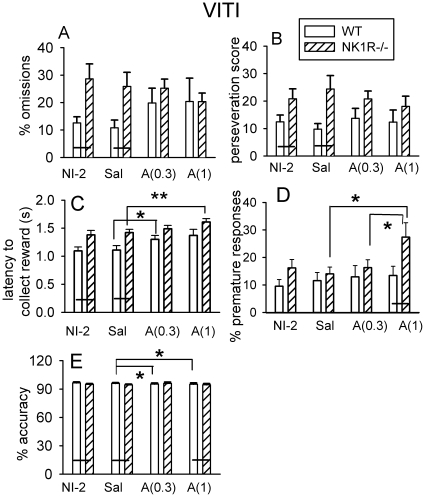
Effects of d-amphetamine on the behavior of wildtype and NK1R-/- mice tested with the VITI in the 5-CSRTT.
d-Amphetamine did not affect % omissions (A) or perseveration score (B) but increased latency to collect the reward in both genotypes (C) and % premature responses in NK1R-/- mice (D). d-Amphetamine slightly reduced the % accuracy of wildtypes, only (E). Bars show mean ± s.e.m for the behavior of either untreated mice, tested for the second time with the VITI (NI-2), or mice given an i.p. injection of saline (Sal) or d-amphetamine (0.3 mg/kg, ‘A(0.3)’ or 1 mg/kg, ‘A(1)’). The mice experienced each treatment once only, at weekly intervals. The sequence of treatments (including NI-2) was pseudo-randomised (Latin-square) across the subjects. The black line linking adjacent bars indicates a genotype difference of P<0.05, at least, regardless of time of day. N = 11-12 per group. * P<0.05, ** P<0.01, *** P<0.001 of comparisons of groups means indicated above the bars.